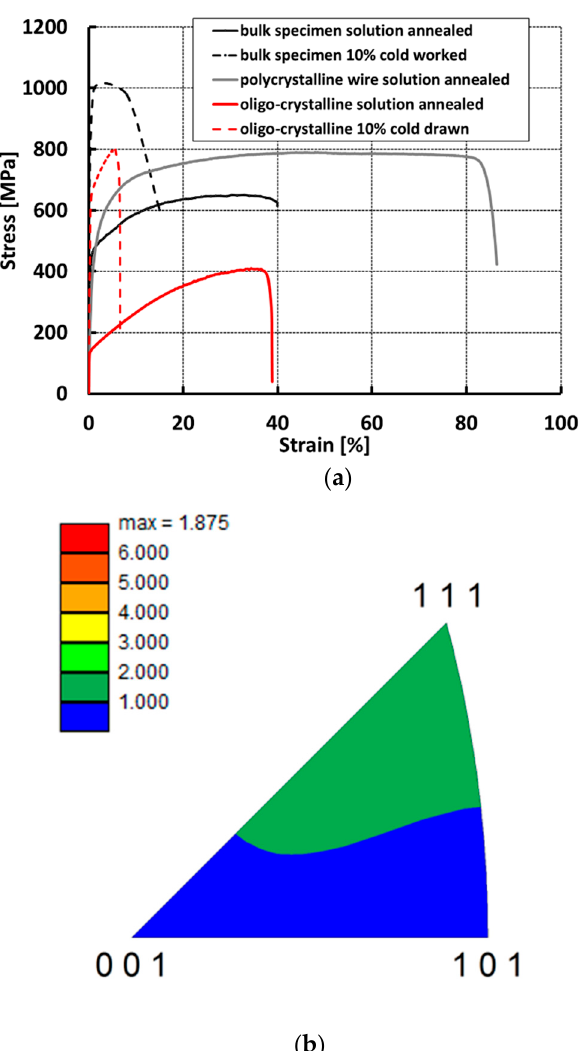
Figure 3. ( a ) Stress–strain curves of oligo-crystalline solution annealed and 10% cold drawn wires in relation to polycrystalline 316LVM bulk specimens (taken from Goebbler [26]) and ( b ) inverse pole figure (IPF) texture map for an oligo-crystalline 10% cold drawn wire before testing.